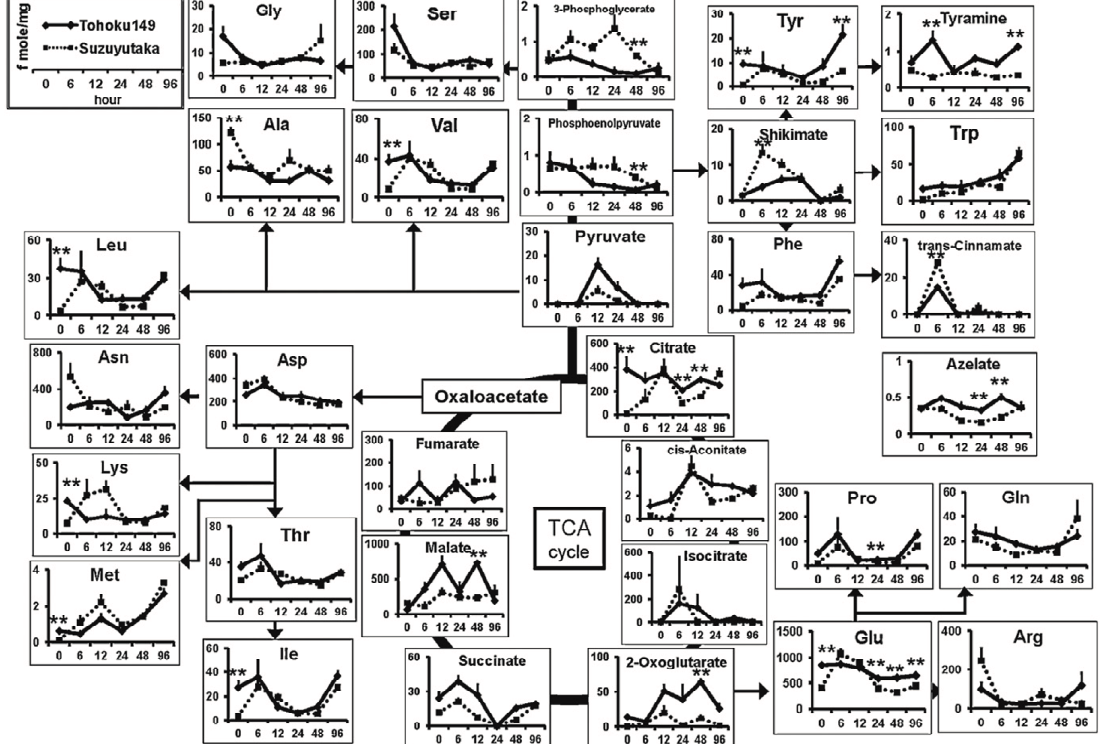
Figure 4. Changes in the level of representative primary metabolites after aphid introduction. Data for the metabolite per mg of soybean leaves (wet weight) at 0–96 h after aphid introduction are plotted. Solid and dashed lines indicate the metabolite concentrations in Tohoku 149 ( n = 5) and Suzuyutaka ( n = 5), respectively. The data points are mean values and the error bars indicate the standard error. Asterisk ( ** ) denotes statistical significance with p < 0.01. Reprinted with permission from